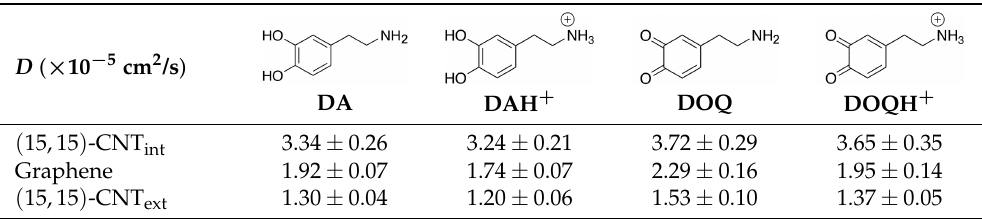
Table 2. 2D diffusion coefficients of DA, DOQ, and their protonated counterparts. The values of the overall 2D diffusion constant, D , were calculated from the MSDs of the adsorbates on the interior of the armchair ( 15,15 ) -CNT, flat graphene, and the exterior of the armchair ( 15,15 ) -CNT. Finite system size results are shown here as calculated within the ≈ 100 Å long